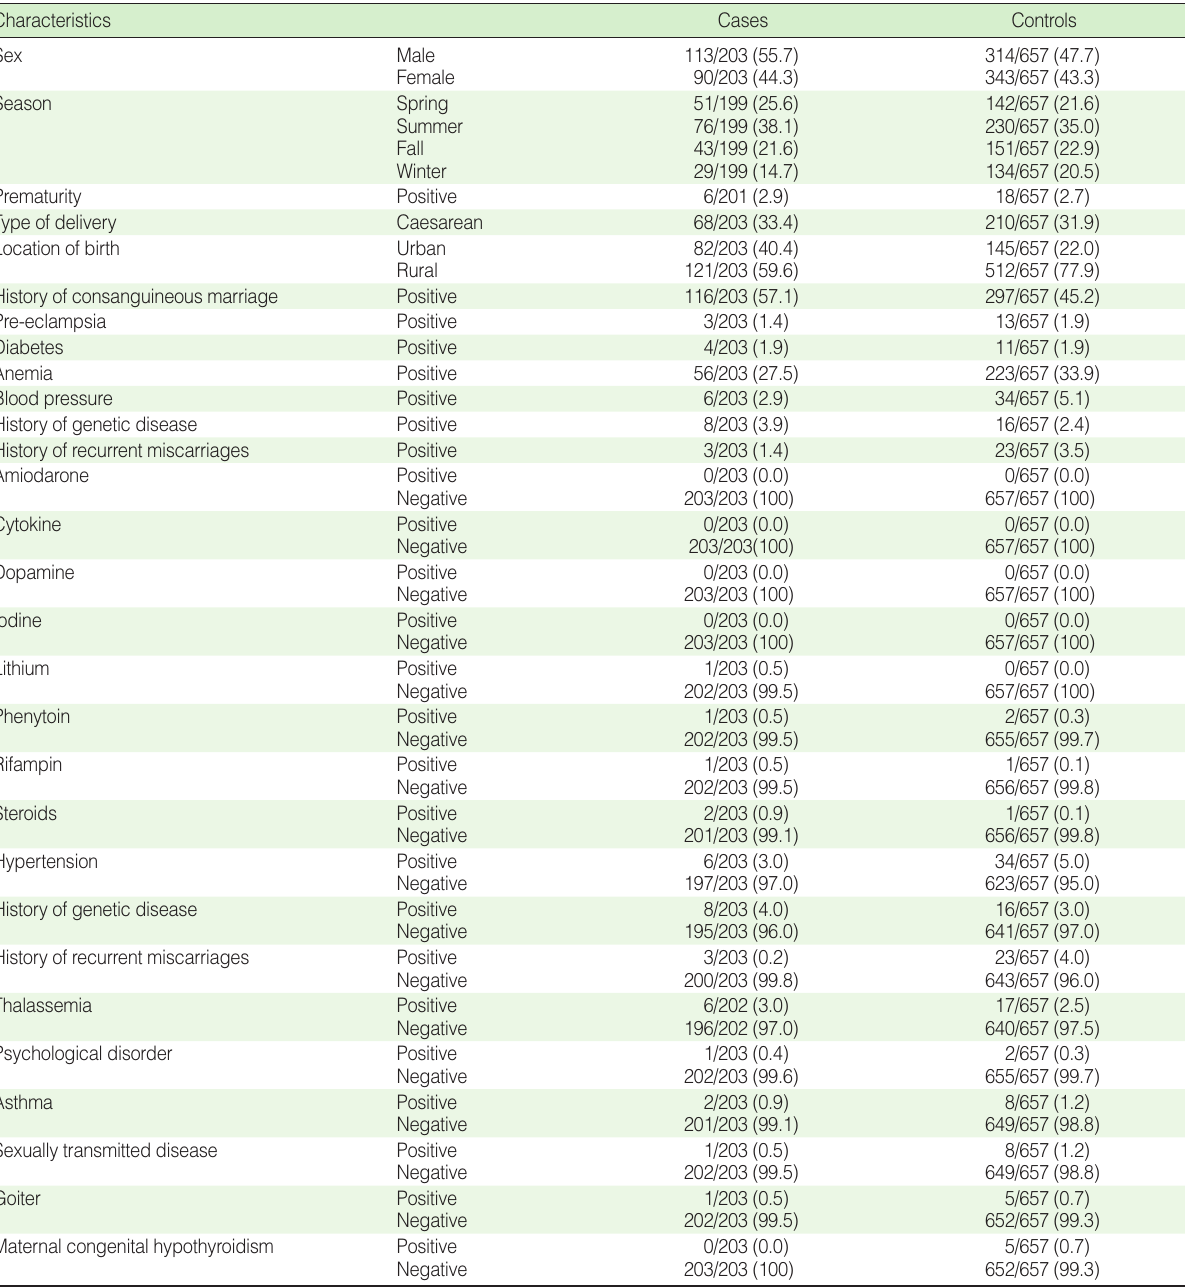
Table 2. Characteristics of the participants in this study (2012-2014)